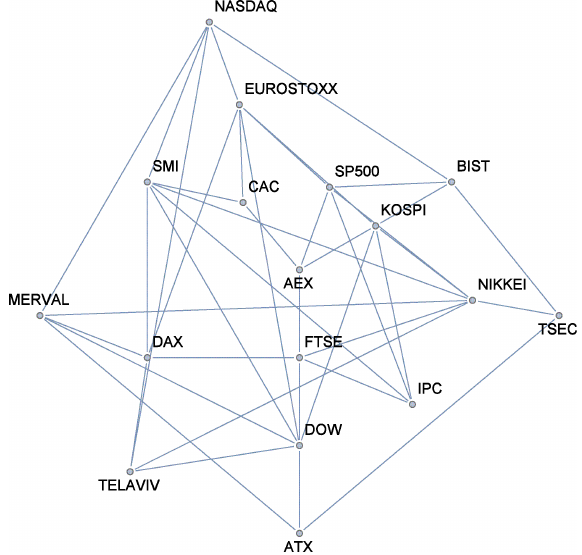
Fig. 3. The network amongst the 17 stock markets that build with the formation rule CorrDist (cid:20) 0:8 . The markets DOW and NIKKEI have the highest vertex degree 7, and the markets with degree 6 are EUROSTOXX, KOSPI,